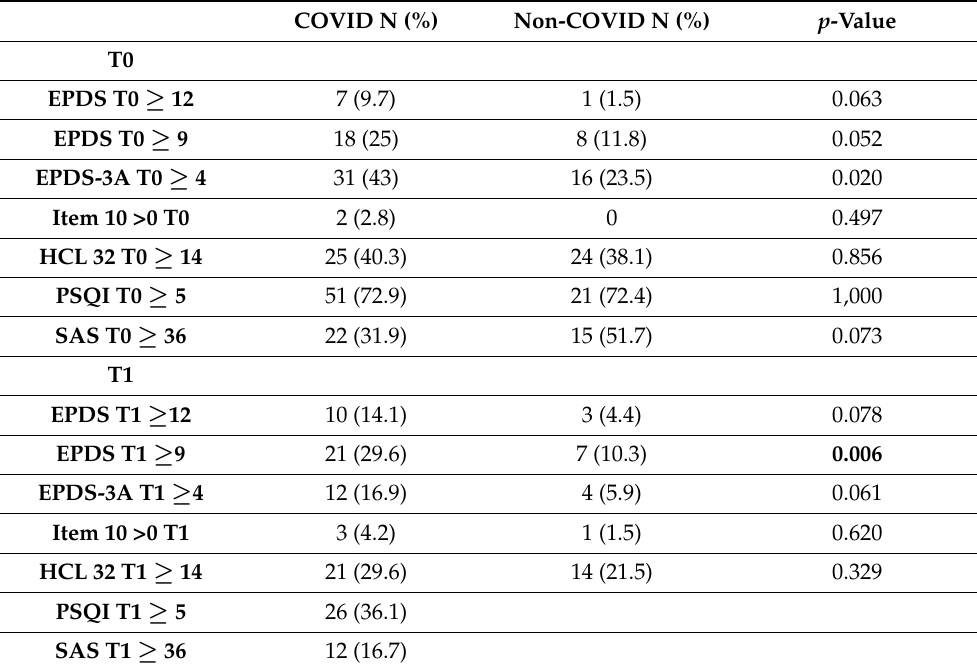
Table 2. Clinical measures: Chi-Square comparisons between COVID and Non-COVID samples.